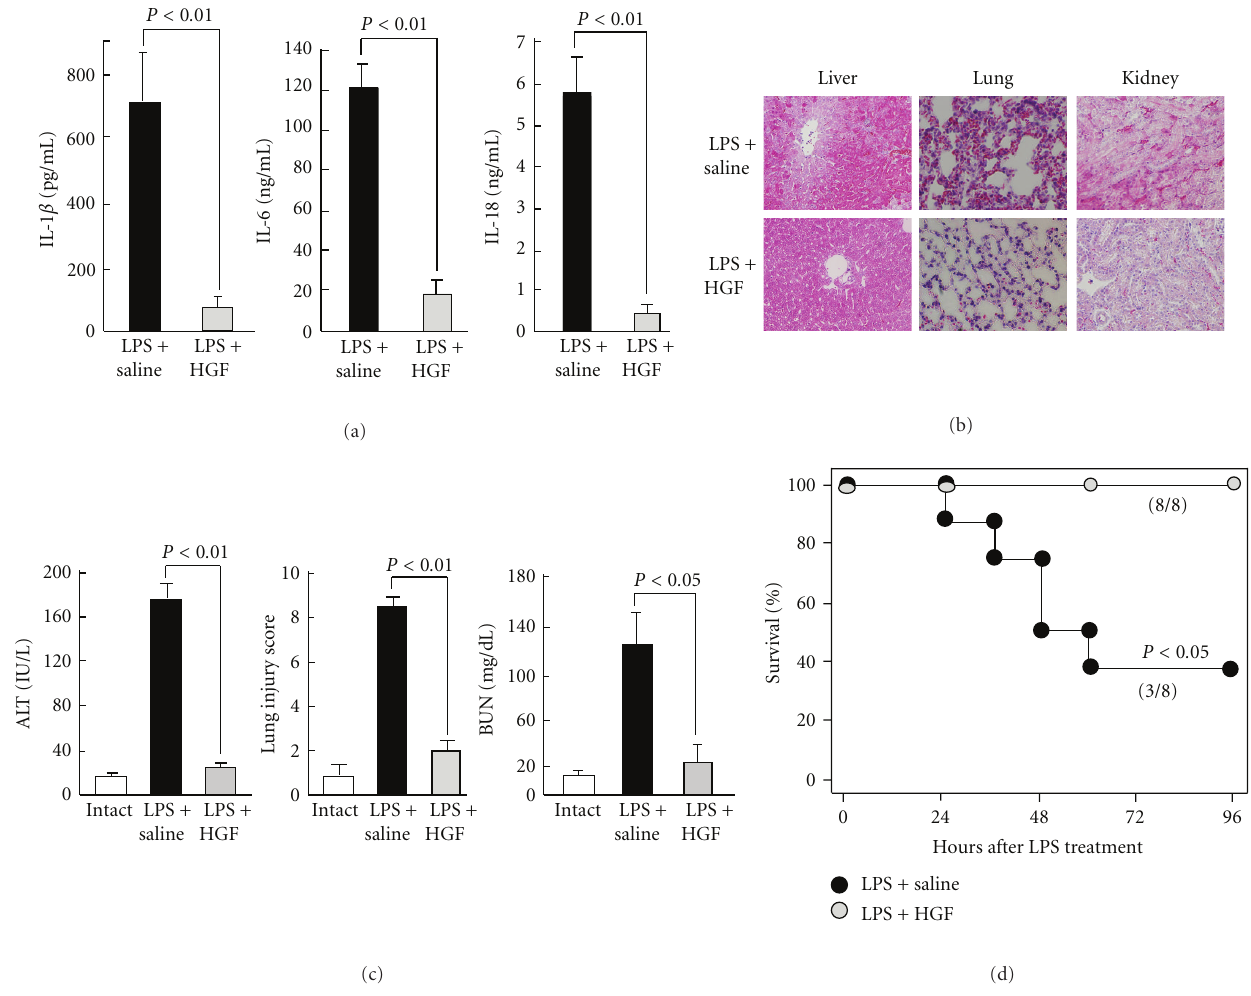
Figure 2: Therapeutic e ff ects of recombinant HGF on MOF induced by LPS in mice. (a) Inhibitory e ff ect of HGF treatment on cytokine storm. LPS-induced increases in plasma IL-1 β , IL-6, and IL-18 levels were inhibited by HGF treatment. There are significant di ff erences between saline- and HGF-treated septic groups (24 hours after challenge, ANOVA test). (b) Attenuations of histological lesions, such as hepatic degeneration, lung edema, and renal congestion by HGF in LPS-treated mice. (c) Prevention of hepatic, pulmonary and renal dysfunctions by HGF in septic mice. ALT: alanine aminotransferase. BUN: blood urea nitrogen. There are significant di ff erences between saline- and HGF-treated septic groups (24 hours after challenge, ANOVA test). (d) Improved survival rate within 4 days after HGF treatment ( n = 8 per group), with a significant di ff erence (96 hours, Kaplan-Meier test). Overall, recombinant HGF was shown to prohibit septic MOF in a mouse model of sepsis [28,